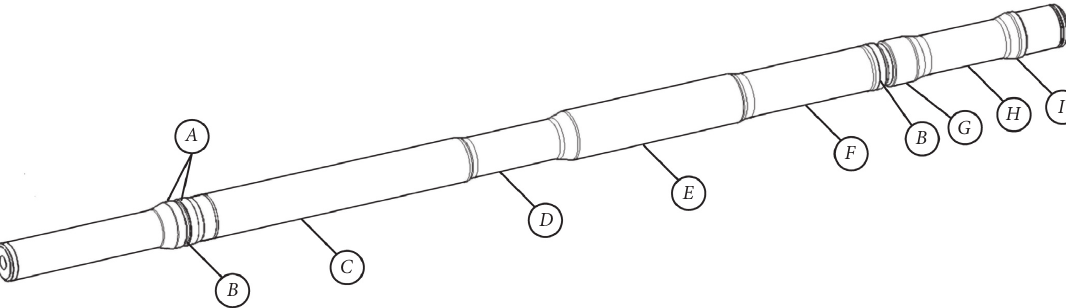
Figure 5: The major axis of half-shaft. Table 3: The radius by each section of the half-shaft.